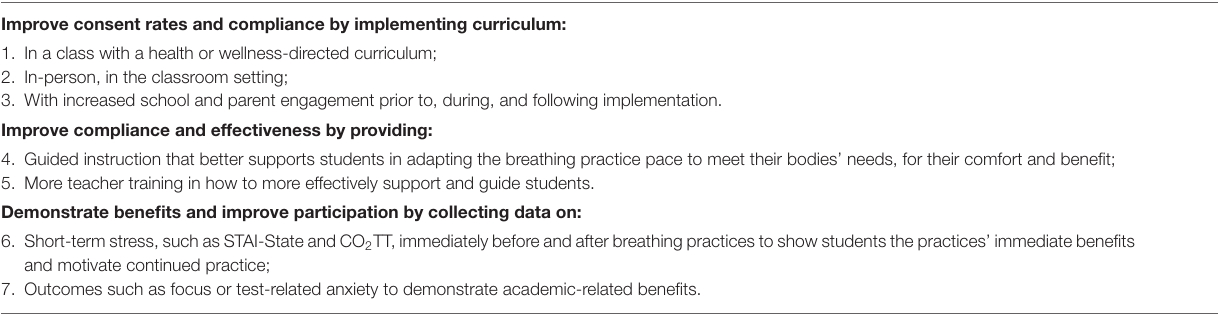
TABLE 5 | Recommendations for future